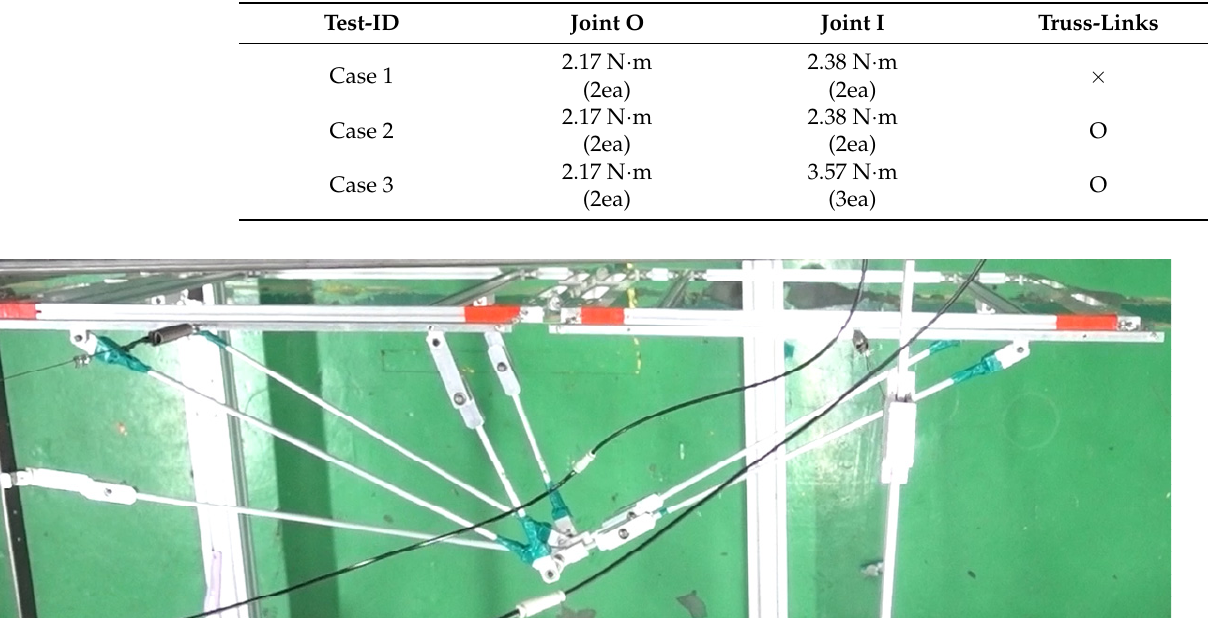
Figure 9. Fully deployed configuration (case 2 and case 3). Table 8. Test cases.